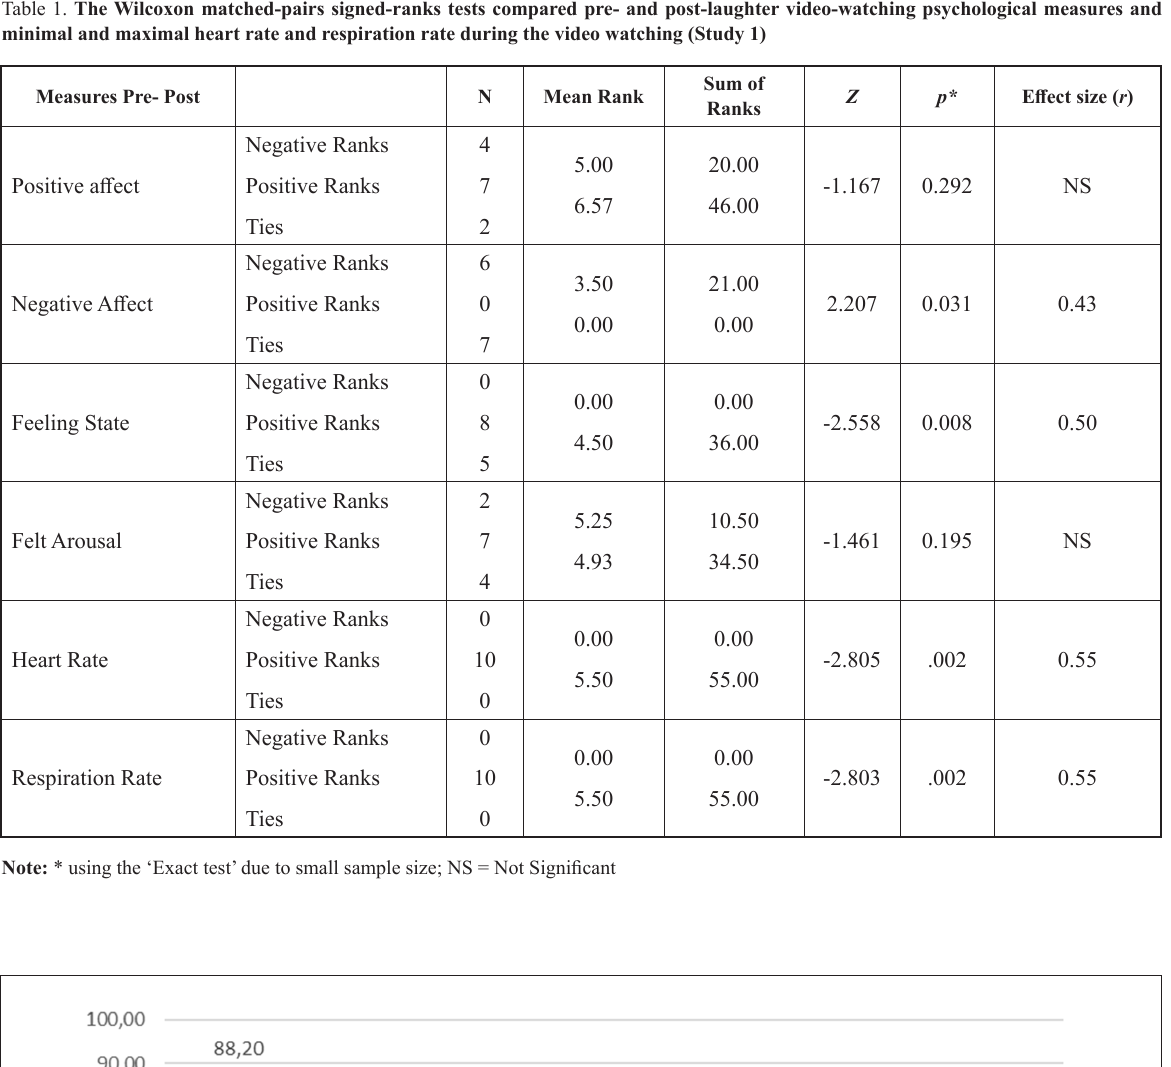
Table 1. The Wilcoxon matched-pairs signed-ranks tests compared pre- and post-laughter video-watching psychological measures and minimal and maximal heart rate and respiration rate during the video watching (Study 1) Measures Pre- Post N Mean Rank